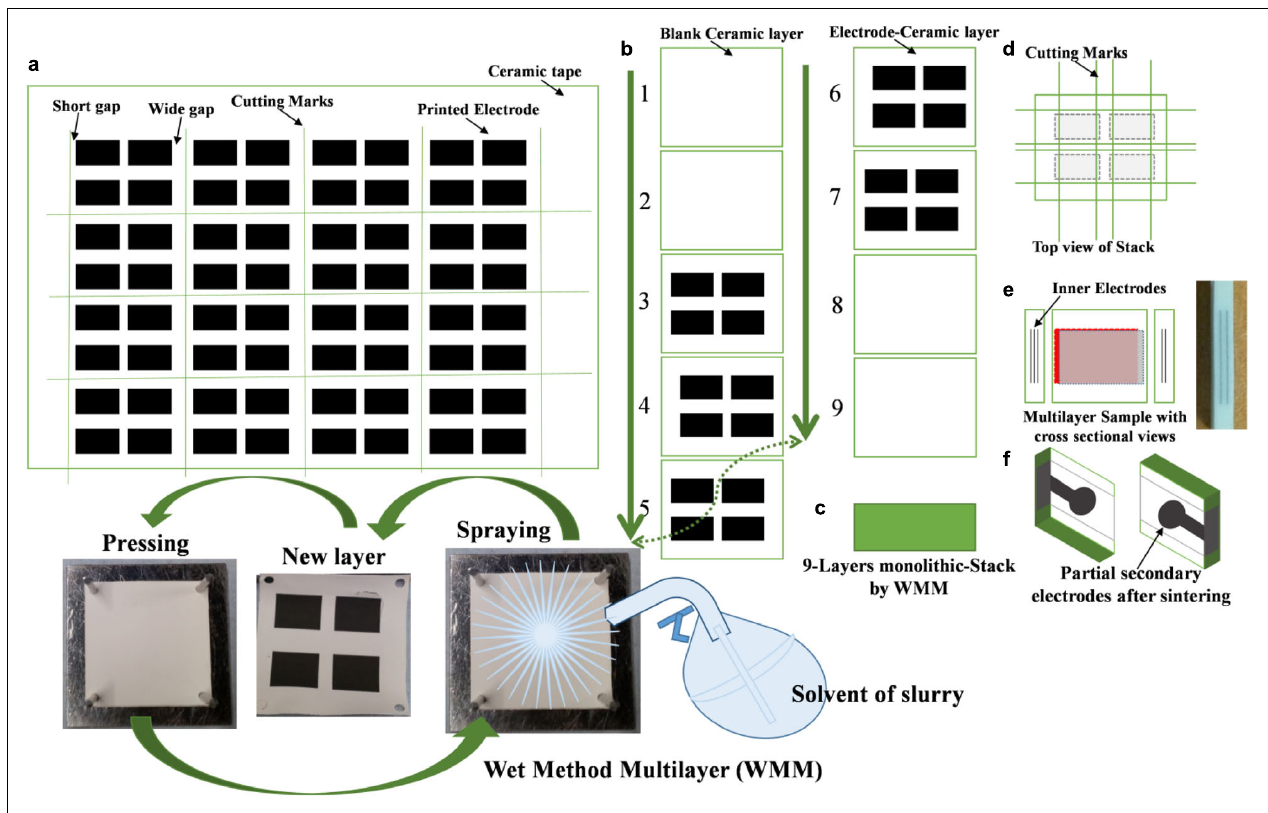
FIGURE 1 | Flow diagram of five-electrode-layers by wet method multilayer (WMM), (a) screen printing of inner electrode, (b) stacking procedure with spraying, (c) stacking view, (d) sample marking/cutting, (e) cross-sectional inner electrode views with real sample, and (f) partial secondary electrode of